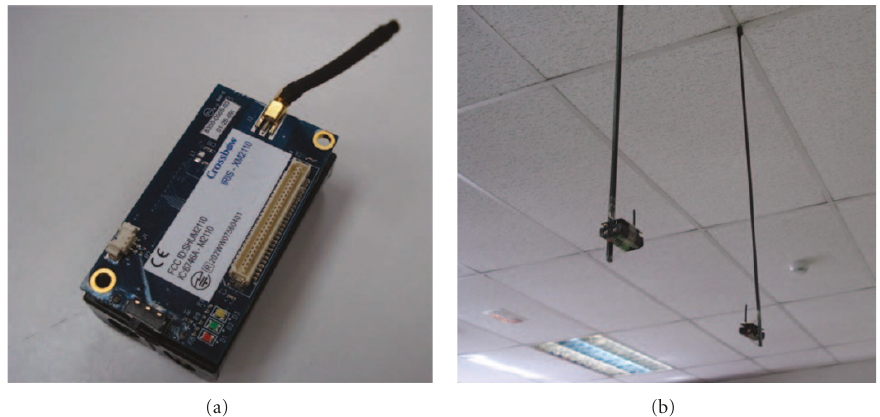
Figure 4: (a) Crossbow’s IRIS wireless sensor node, (b) Illustration of the experiment in our